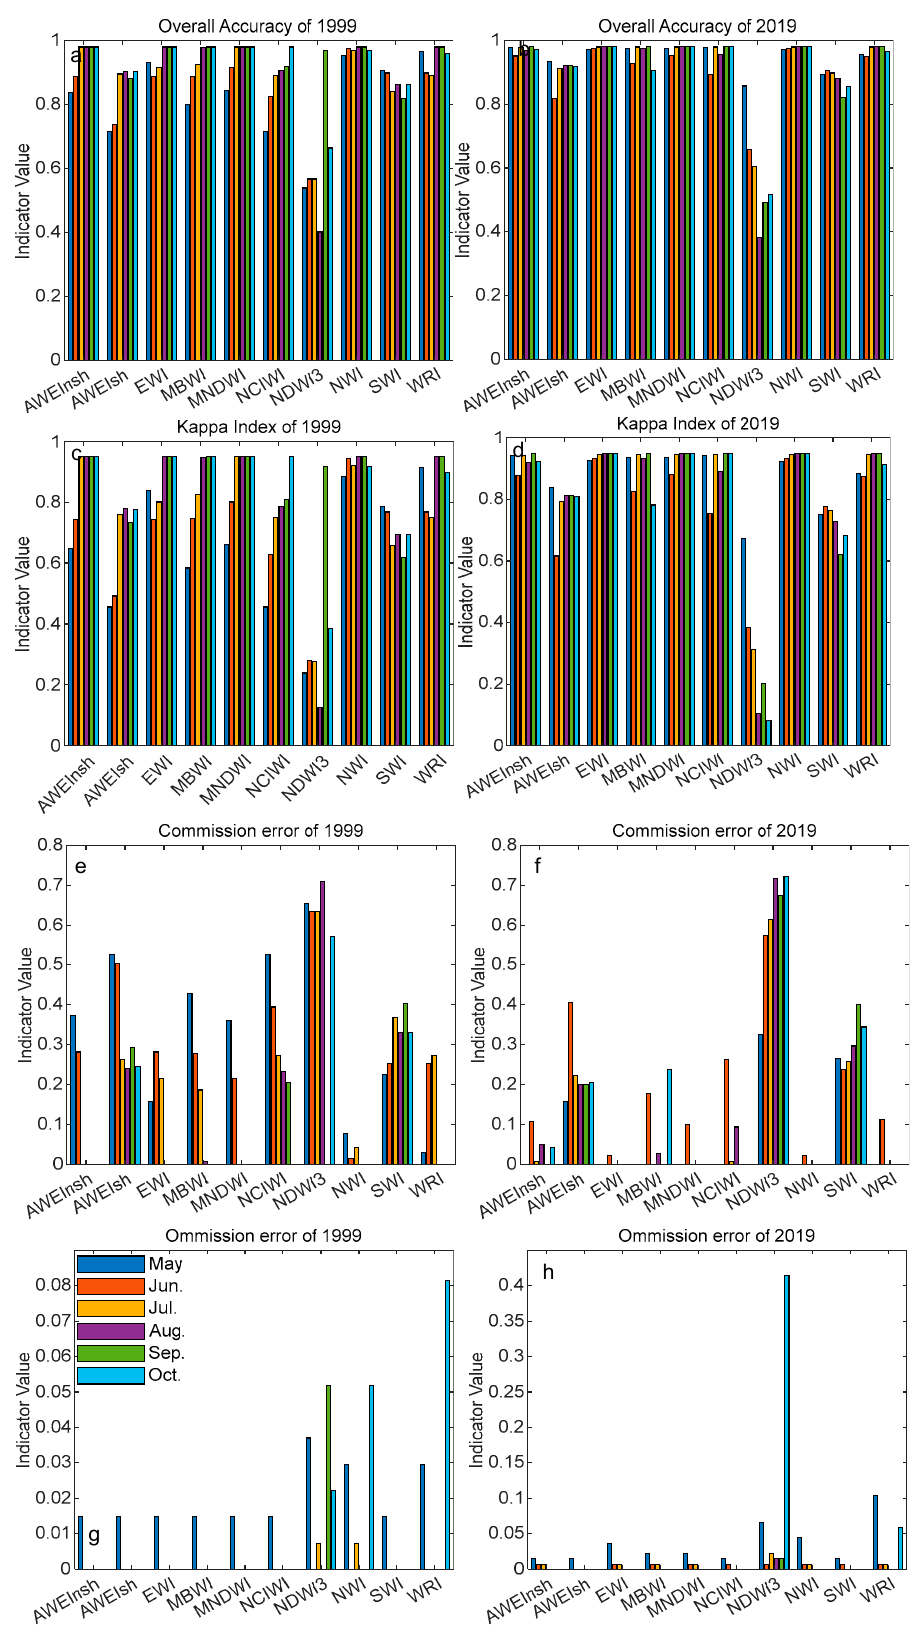
Figure 12. Evaluation plots of the OA ( a , b ), Ka ( c , d ), CE ( e , f ) and OE ( g , h ) for water extraction in the study area of Songhua Lake based on the water indices with their optimal segmentation thresholds from May to October in 2000 and 2021, respectively.